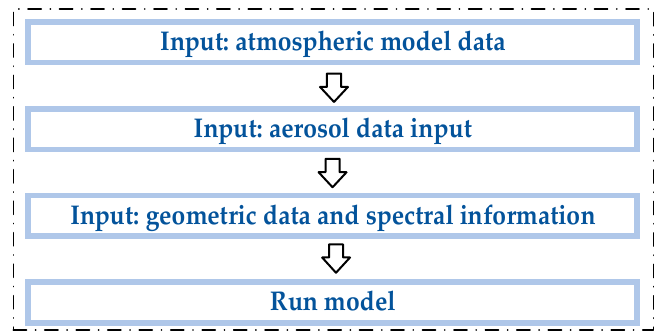
Figure 2. The brief MODTRAN5 process. The spectral radiation characteristics of RAM-C II and HTV-2 HTs observed by space-based low earth orbit (LEO) detectors under different flight states were calculated based on the geometric model and the flow field distribution of these two HTs [38,39]. The results are shown in Figure 3, indicating the intensities of the calculated spectral features not of the same order of magnitude. Moreover, it is impracticable for space-based detectors to obtain all the spectral bands of radiation characteristics of HTs. Therefore, 120 wavebands were selected and normalized at the radiation intensity peak, as shown in Figure 4. To more clearly reflect the intraclass and interclass variation of the HFs of HTs, principal component analysis (PCA) was carried out on HFs, and the result is shown in Figure 5 and Table 1. The pink represents the HTV-2 HTs, and the blue represents the RAM-C II HTs. We can see in Figure 5 that the HFs of the same type of HTs were different when the flight states changed. When combined with the specific values in Table 1, this shows that different types of HTs flying in the same state have small HF differences.